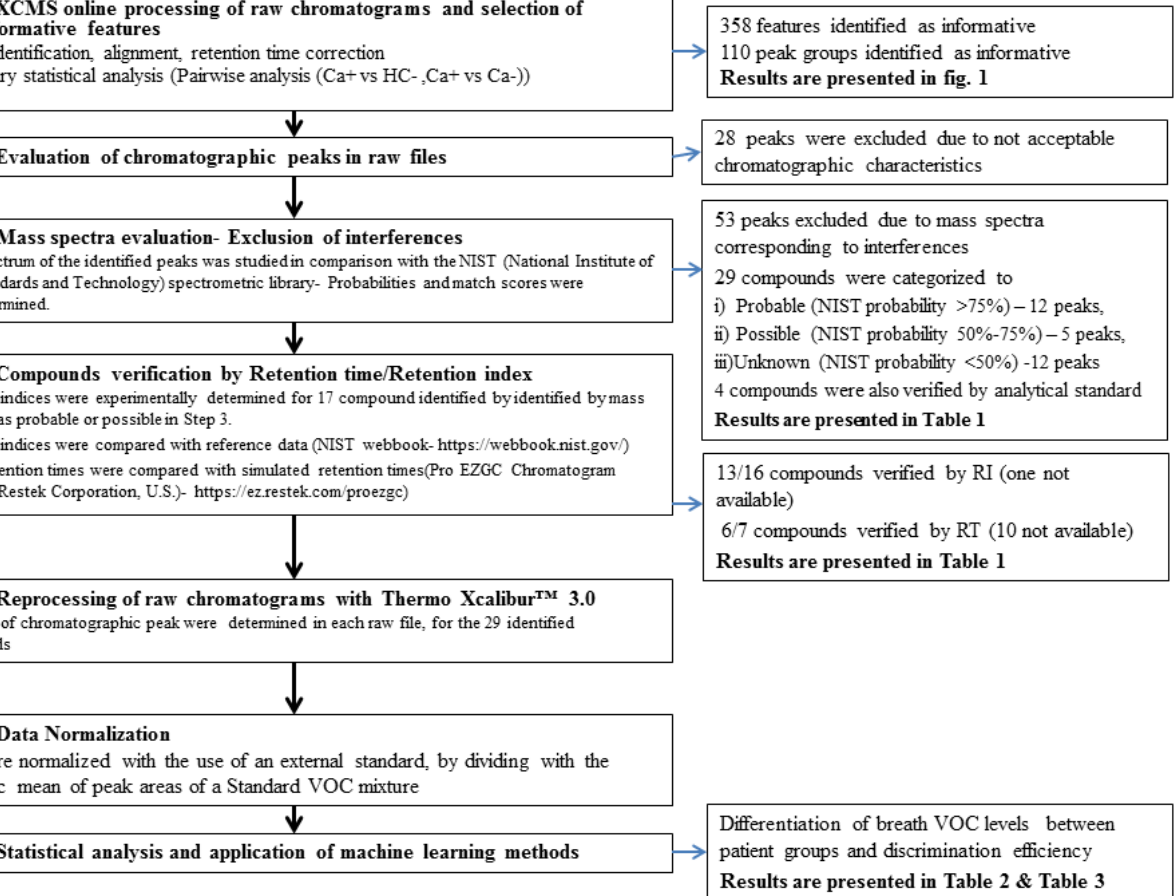
Figure 2. Flow chart of the process applied for selecting, identifying and processing informative compounds. Table 1. Identification of compounds based on spectra comparison with NIST library and retention time criteria.